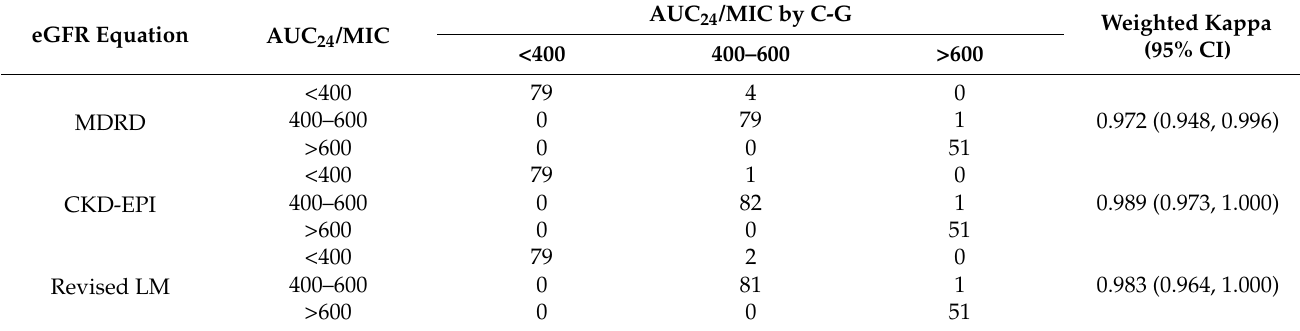
Table 3. Agreement between Cockcroft-Gault and the other eGFR equations for prediction of AUC 24 /MIC.